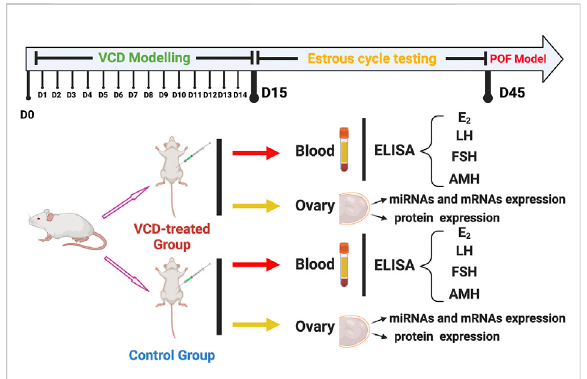
The experimental design of this study. The SD female rats divided into two groups: The VCD-treated group and Control group. The two group rats were sacri fi ced at the same time every day (D1-D15) for 15 consecutive days. After estrous cycle testing, the POF model rats also were collected. Each rat was detected with serum hormone levels (E 2 , LH, FSH, and AMH) and screened for early differential expression of target miRNAs from those signi fi cantly differentially expressed on POF model rats (miRNA-190a-5p,miRNA-98-5p,miRNA-29a-3p,miRNA-144-5p, miRNA-27b-3p, and miRNA-151-5p). Subsequently, ovarian tissues from rats on the 6th (D6), 10th (D10), 15th (D15), and 45th (D45) of VCD injection were selected to detect the expression levels of target genes of target miRNAs and mRNAs and proteins on the primordial follicle hyperactivation signaling